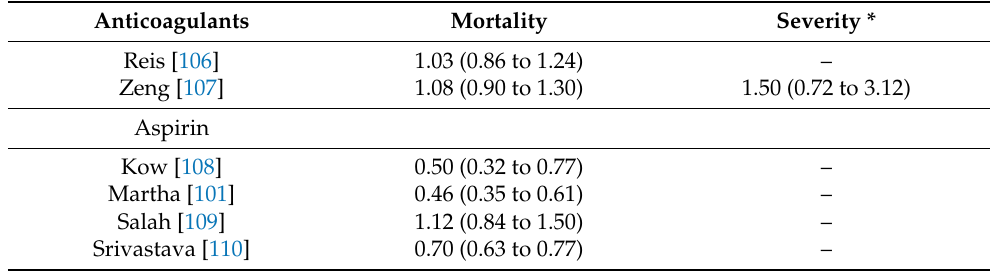
Table 5. Odds ratio (95% confidence interval) of the effects of anticoagulants and aspirin on COVID-19